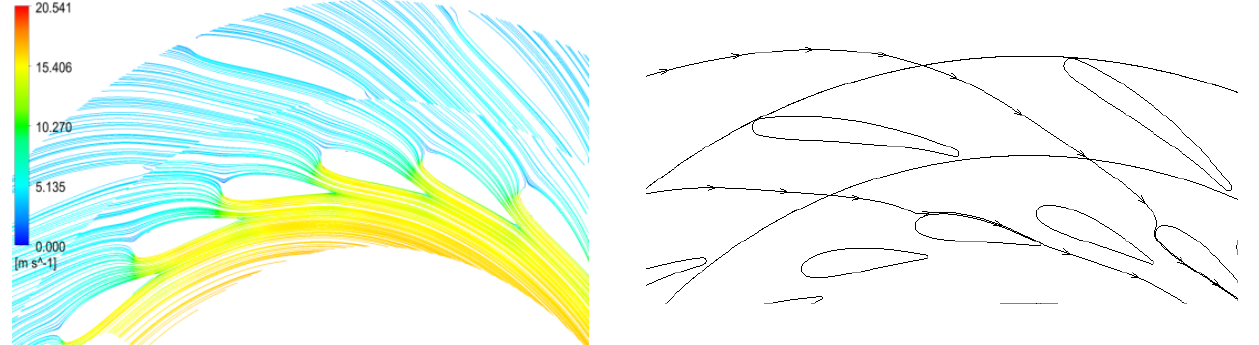
Figure 3. ( a , b ) Sketch of guide vane opening of 64.3%, 81% sketch.